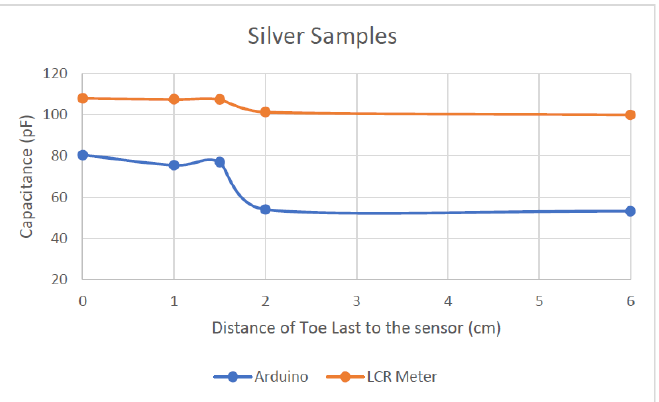
Figure 22. Silver sample capacitance readings comparison between Arduino and LCR meter.